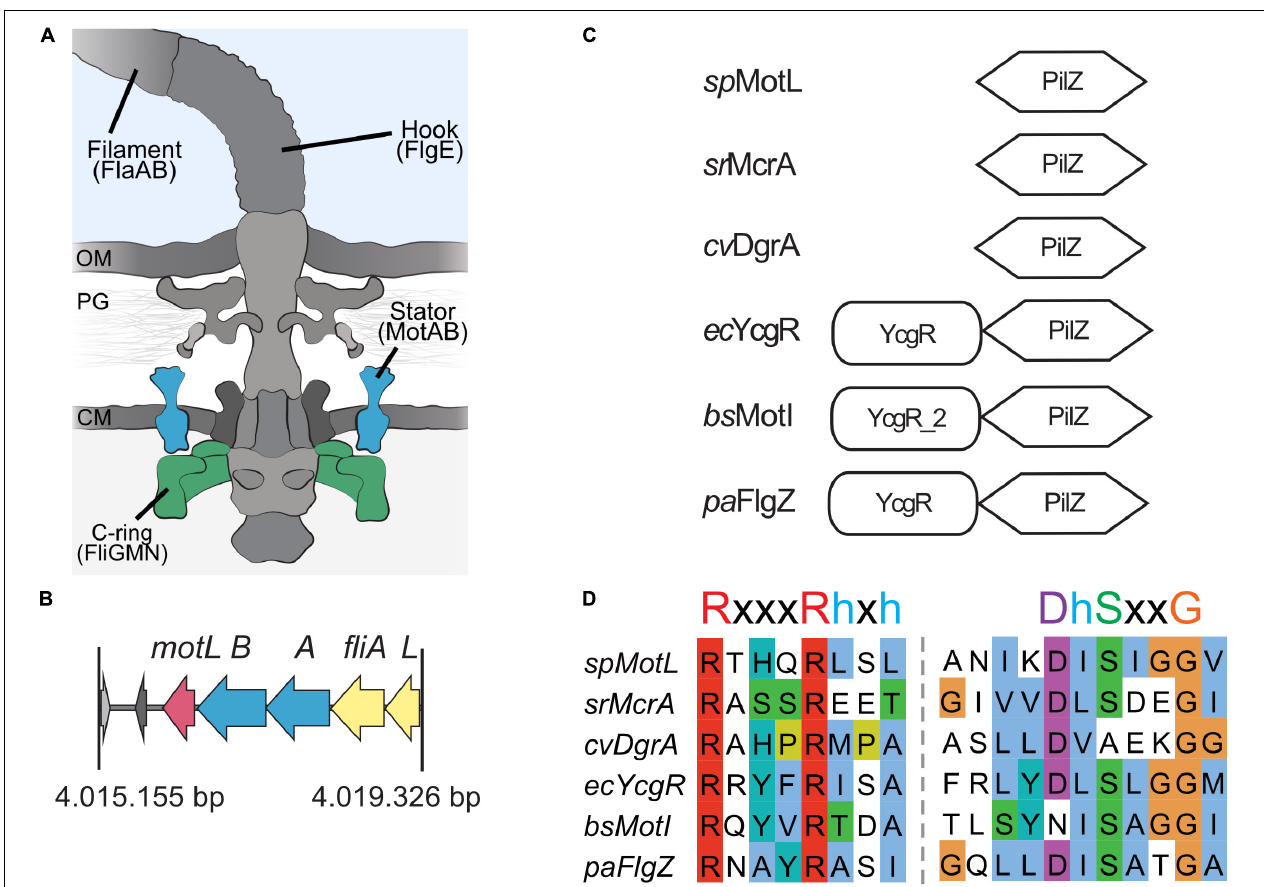
FIGURE 1 | MotL is a putative c-di-GMP-binding PilZ domain-only protein. (A) Cartoon of the flagellar motor with the major components (filament, hook, and basal body containing a type III export machinery and the flagellar motor). Torque to drive rotation of the Shewanella putrefaciens lateral flagella is created between the stator subunits (proteins MotA and MotB, blue) and the cytoplasmic C-ring (proteins FliG, FliM, and FliN, green). OM, outer membrane; PG, peptidoglycan; CM, cytoplasmic membrane. (B) Organization of the motL gene region in S. putrefaciens , motL is immediately following downstream of the genes motA and motB that encode the stator subunits. (C) Domain organization of PilZ proteins implicated in the regulation of flagella-mediated motility. See text for details. (D) Alignment of the PilZ domains of the proteins given in panel (C) . The residues critical for c-di-GMP binding are marked above the